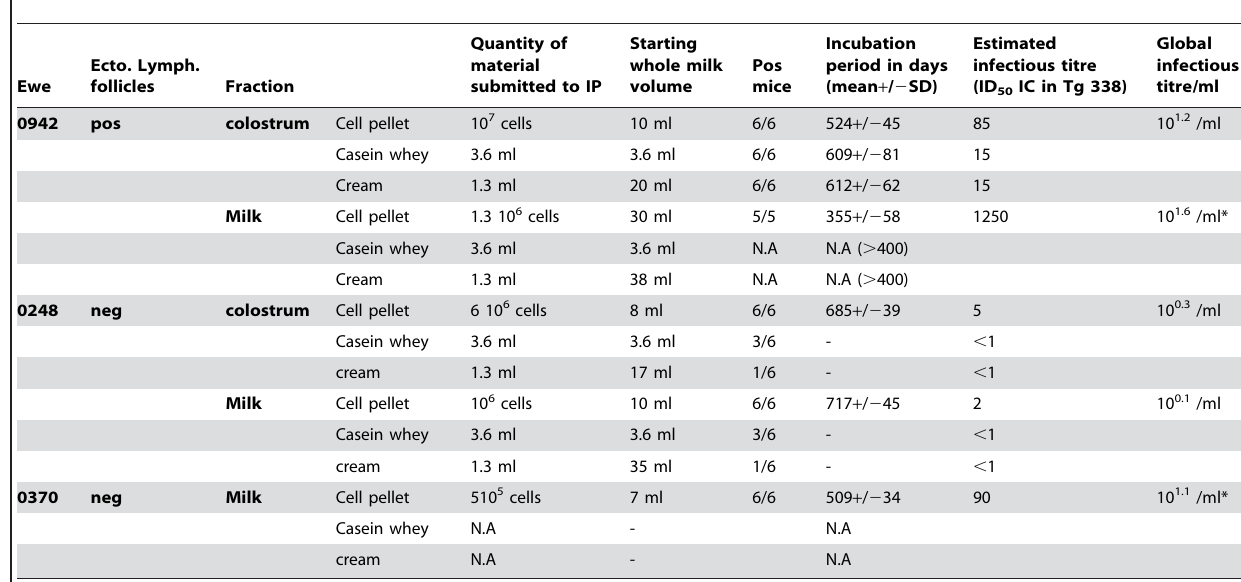
Table 4. Estimation of infectious titre in colostrum and milk from scrapie incubating ewes with apparently healthy mammary glands or lymphoproliferative mastitis (consecutive to Maedi